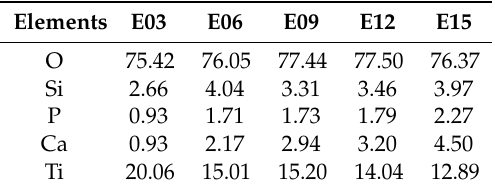
Table 1. Elemental content of micro-arc oxidation coatings (at